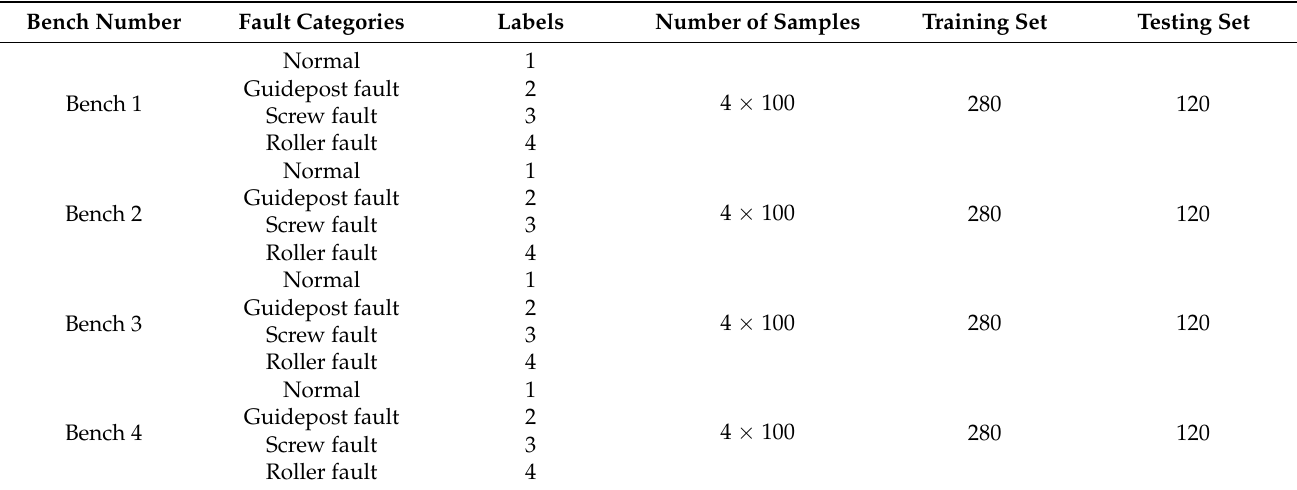
Table 5. Details of the four bench datasets.